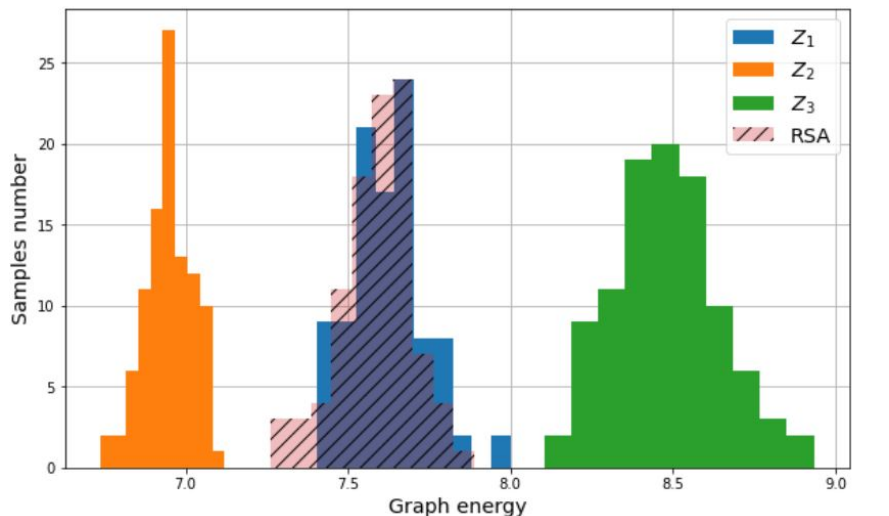
Figure 10. Summary of the results obtained for the Z-dsitributions and RSA. The RSA results are shown by the hatched histogram.